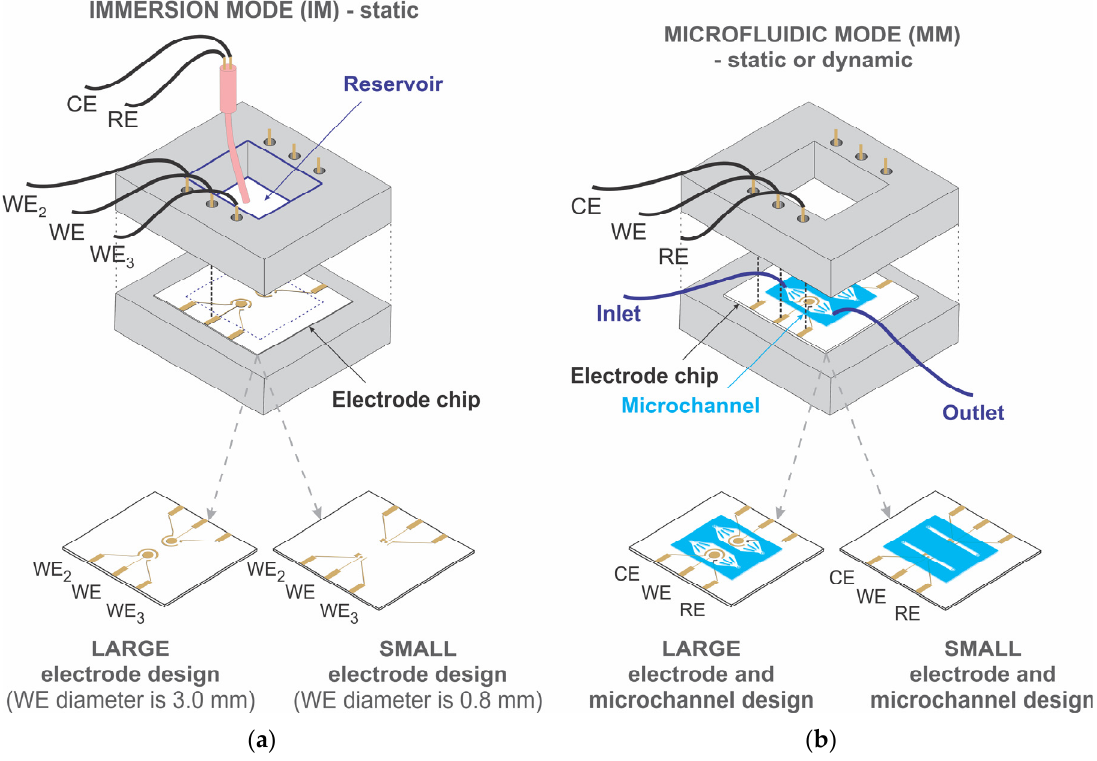
Figure 2. Two approaches of biosensor construction: ( a ) immersion mode (IM) biosensor—thin films WE, WE 2 , WE 3 and externally immersed CE and RE.; ( b ) microfluidic mode (MM) biosensor—thin films WE, CE and RE, which are integrated into the microchannel. Both modes include large and small electrode and microchannel designs.